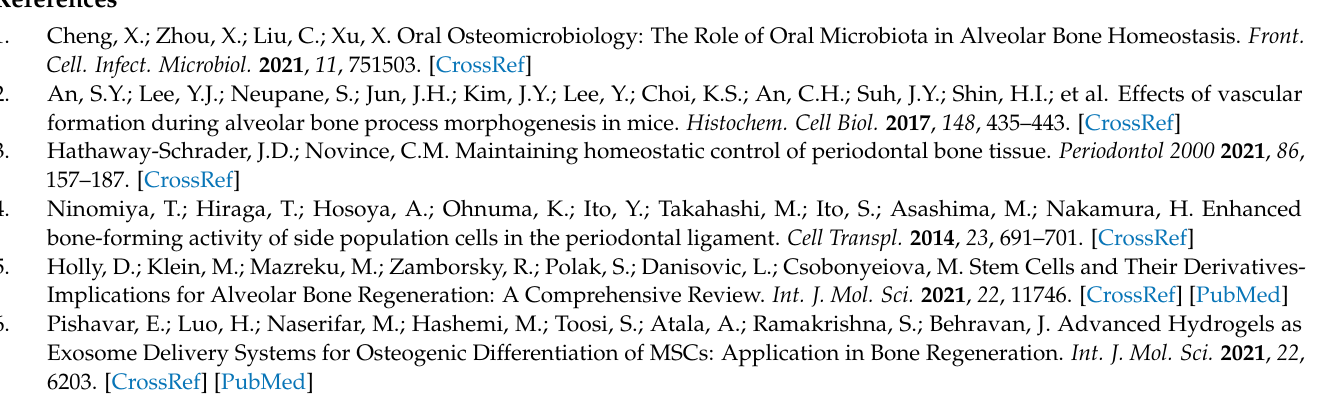
repeated three times. Table S1: Targeted knockdown using shRNA sequences; Table S2: qPCR primer sequences for ChIP; Table S3: Primer sequence for